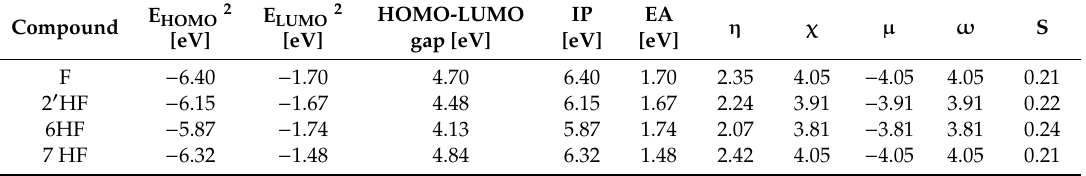
Table 2. Quantum chemical descriptors for F, 2 ’ HF, 6HF and 7HF ( hardness ( η ); electronegativity ( χ ); chemical potential ( µ ); electrophilicity index ( ω ); softness (S)) calculated from ionization potential (IP) and electron a ffi nity values (EA), which were estimated by orbital vertical method.